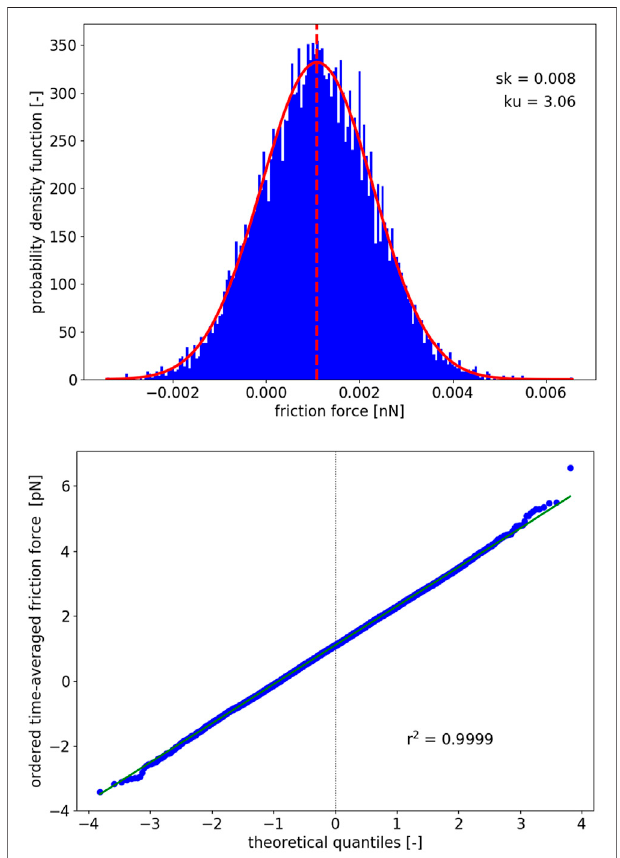
force (blue) for the same sliding experiment repeated 10 4 times together with the corresponding normal (Gaussian) distribution (solid red line) and the mean (dashed red line). Here the skewness (sk) and kurtosis (ku), i.e., the third and fourth central moments, are measuring the high quality of the normal distribution for the time-averaged friction force. This is additionally also quanti fi ed by Pearson ’ s linear correlation coef fi cient r 2 in the bottom panel , where the probability plot of the time-averaged friction force is